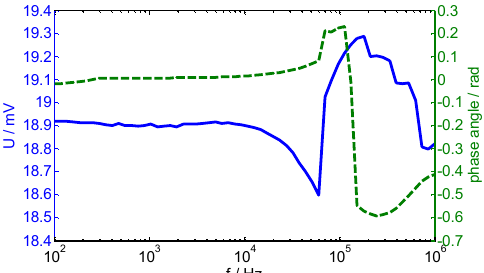
Fig.11: Magnitude (solid line) and phase angle (dashed line) of the applied voltage.